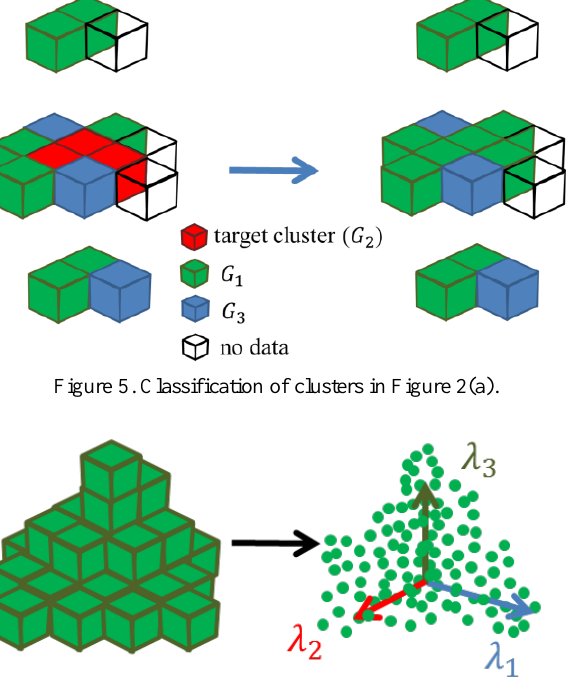
Figure 6. Approximate curvature of clusters in Figure represent a target cluster. The surrounding voxels are the thirteen voxels connected with the cluster. Blue and green voxels correspond to G 1 and G 3 , respectively, and a transparent one means no data. The cluster is re-classified with Equation (3).